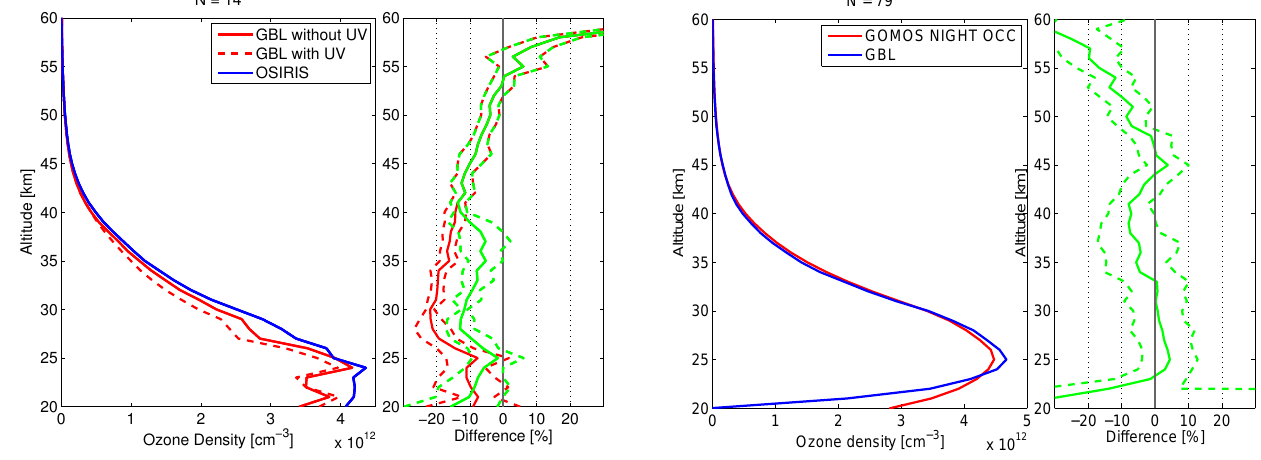
Fig. 10. Comparison of the 79 GOMOS bright limb profiles and GOMOS night occultations at the equator. Left panel: medians of the distributions. Right panel: median of the individual relative differences (solid) and the 25th and 75th percentiles (dashed).